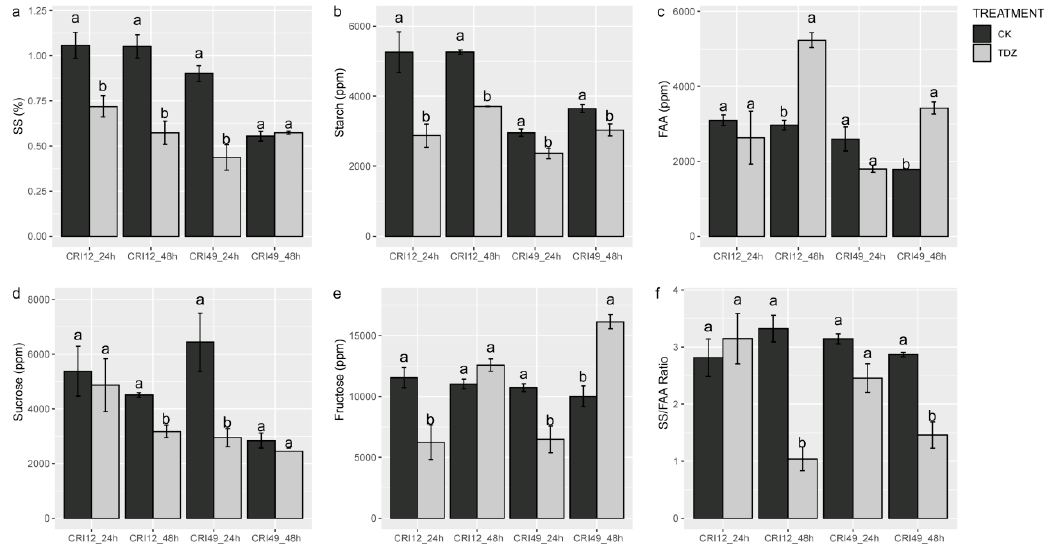
Figure 4. Soluble sugar (SS), sucrose, starch, fructose, and free amino acid (FAA) contents of leaf under TDZ treatment for 24 and 48 h. ( a ) The content of soluble sugar; ( b ) The content of starch; ( c ) The content of free amino acid; ( d ) The content of sucrose; ( e ) The content of fructose; ( f ) The ratio of soluble sugar and free amino acis. CK and TDZ represent control (without TDZ treatment) and 100 mg L − 1 TDZ treatment, respectively. Values not sharing a common letter within the same column are significantly different ( p < 0.05) according to Duncan’s test using SAS software.